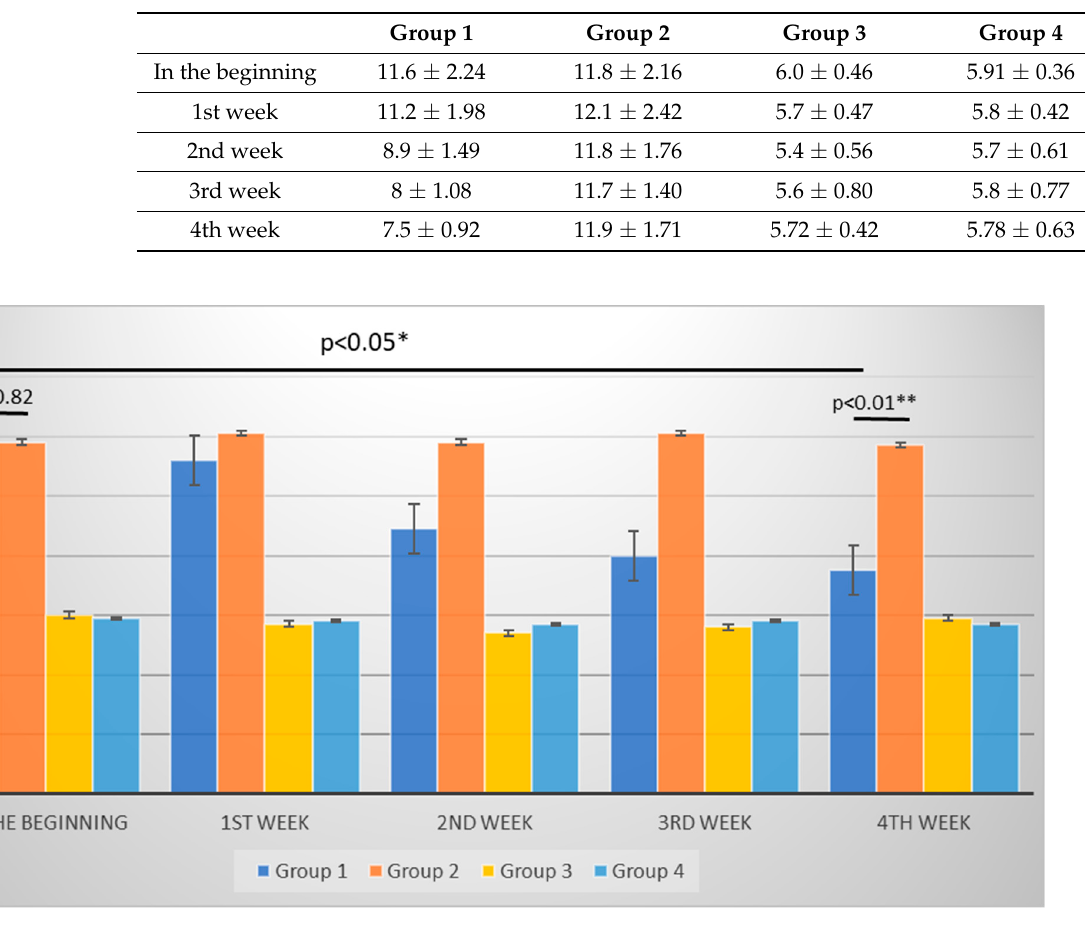
Table 3. The average levels of blood glucose levels of the rats in the different groups during the study ± standard deviation (SD).